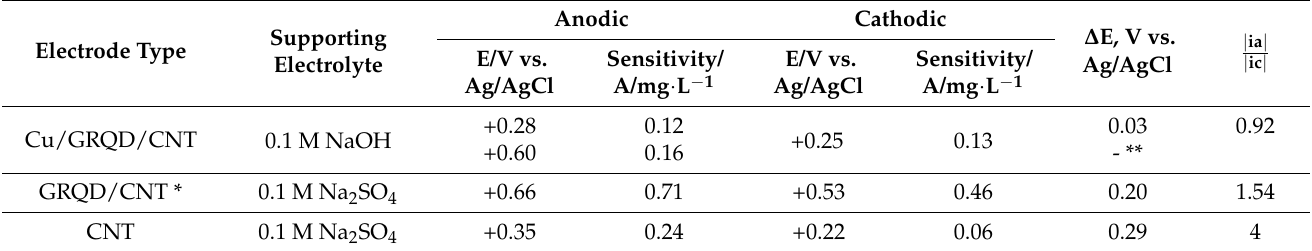
Table 2. Detection potential values and the sensitivity for DOX